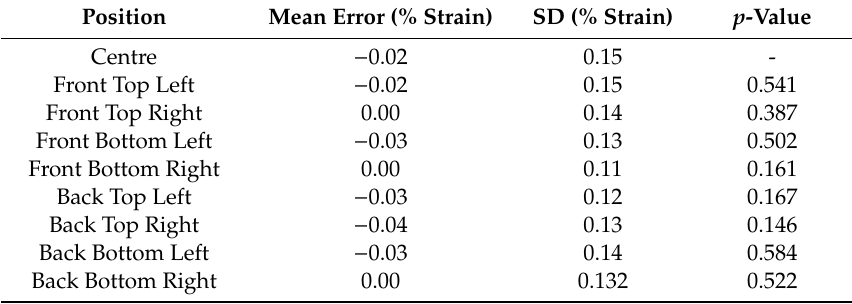
Table 6. p -values from two sample Kolmogorov–Smirnov (K–S) tests comparing error distributions at the 50% deformation stage between measurements made at di ff erent locations within the measurement volume relative to the centre position